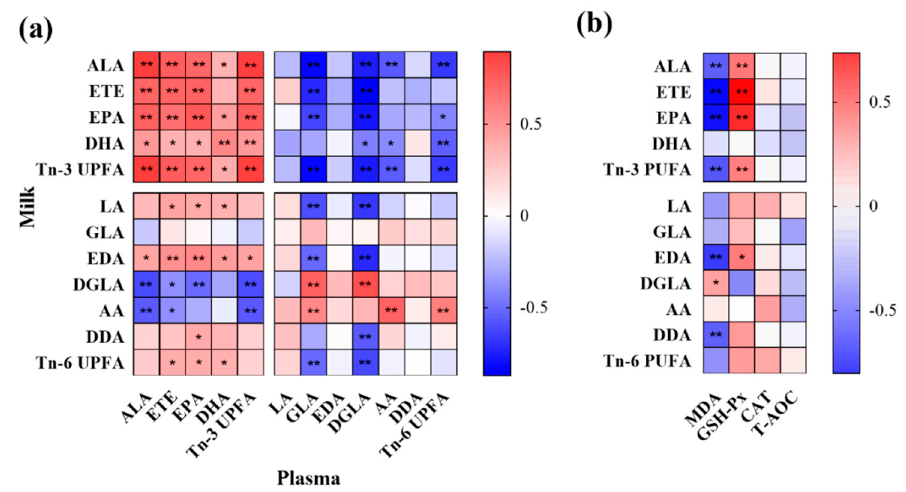
Figure 1. ( a ) Correlation analysis between the n-3 PUFA and n-6 PUFA levels in milk and plasma; ( b ) the antioxidant indexes and the n-3 PUFA and n-6 PUFA in milk. Red represents a positive correlation and blue represents a negative correlation. Significant correlations: * p ≤ 0.05, ** p ≤ 0.01.